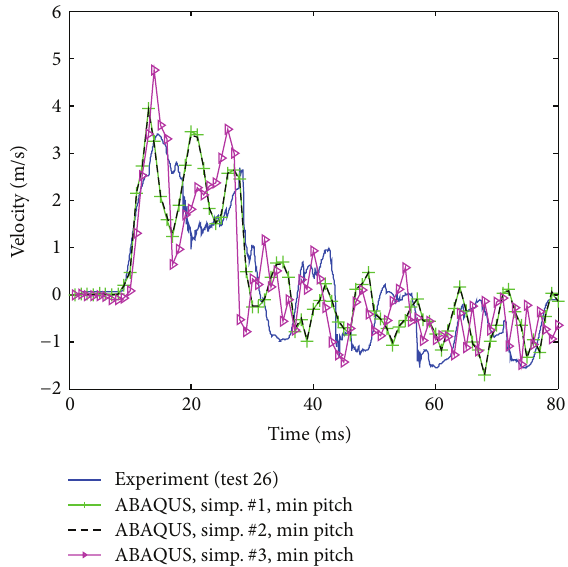
Figure 15: Velocity results for dynamic tension test, simplified model